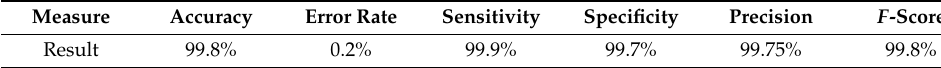
Table 16. Evaluation measures for the optimized ORB algorithm over the 1500 patches.